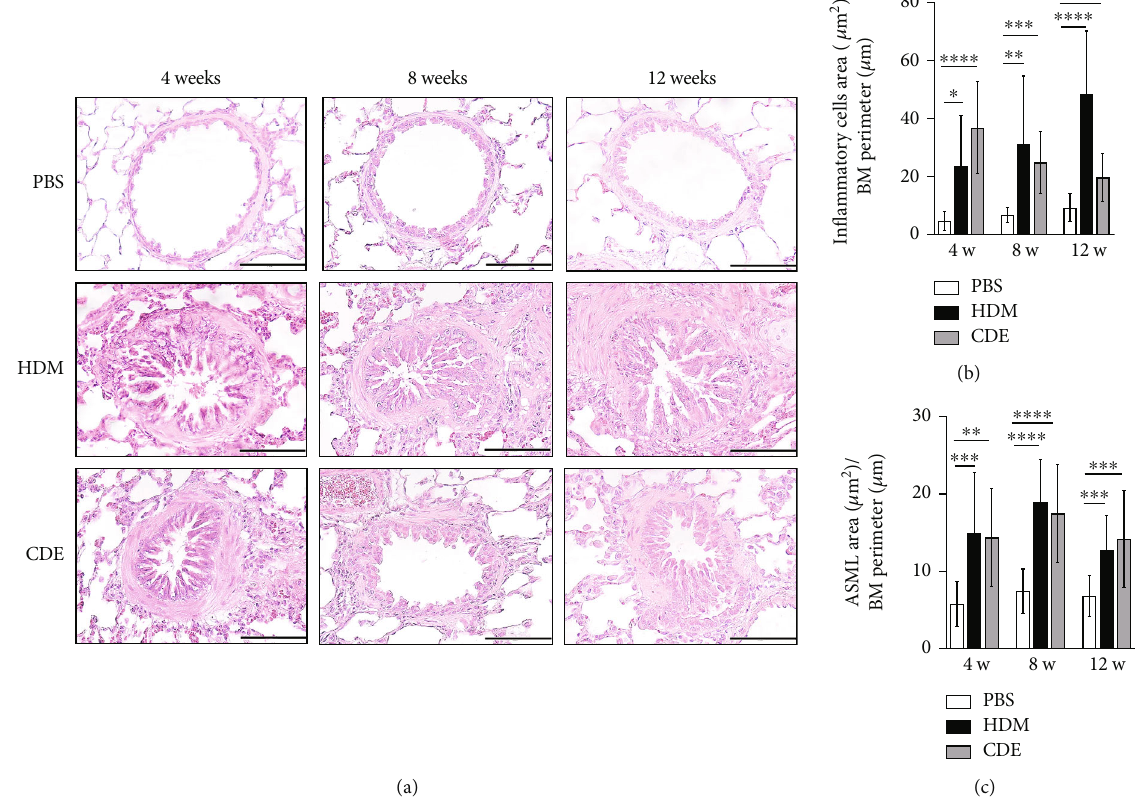
Figure 2: Guinea pigs exhibit a marked in fl ammatory reaction and remodelling to clinically relevant allergens, HDM and CDE. (a) Representative histological sections of H&E-stained lungs. (b) Analysis of in fi ltration of in fl ammatory cells in fi ltrated into the airway subepithelial region and (c) airway smooth muscle thickness. All measured areas ( μ m 2 ) were adjusted by the basement membrane (BM) perimeter ( μ m). Data are the mean ± SD of n = 4 -5 animals per group. Scale bars correspond to 100 μ m. ∗ P < 0 : 05 , ∗∗ P < 0 : 01 , ∗∗∗ P < 0 : 001 , and ∗∗∗∗ P < 0 : 0001 . ASML: airway smooth muscle layer; BM: basement membrane; HDM: house dust mite extract; CDE: cat dander